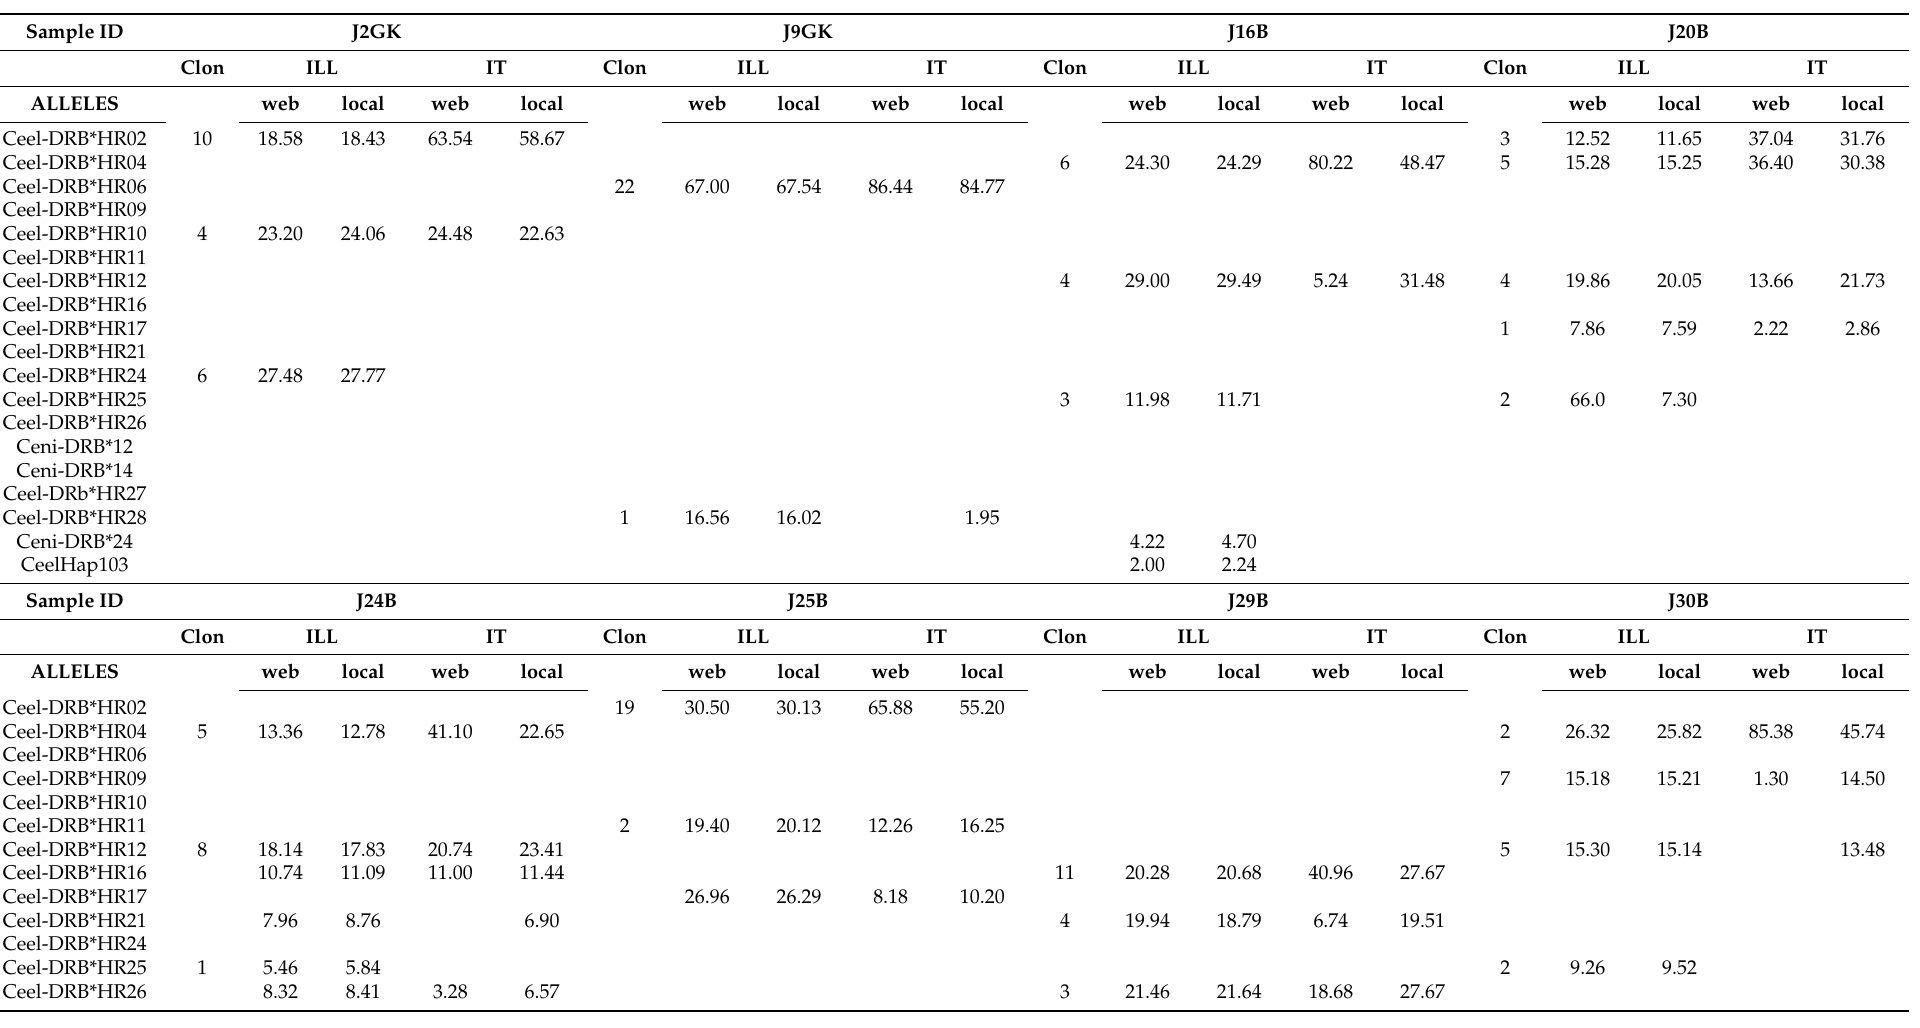
Table 2. Number of detected sequences with molecular cloning (Clon) and frequencies of reads corresponding to each allele (%) obtained using AmpliSAS web and local versions after Illumina (ILL) and Ion Torrent (IT) sequencing of 10 red deer at MHC-DRB